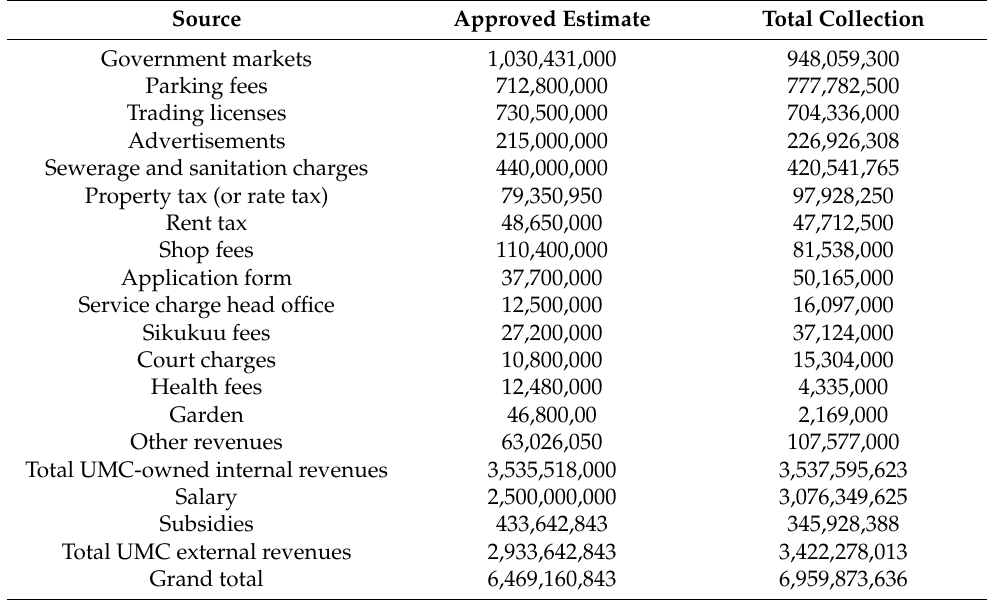
Table 1. Local revenue by source: Fiscal Year 2017/2018 (unit: TZS). Source Approved Estimate Total